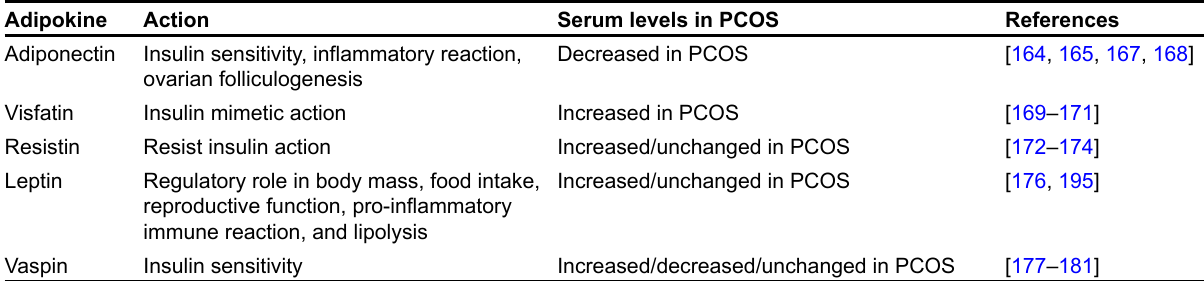
Figure 4. Proposed mechanism of interconnection between adiposity, hyperinsulinemia, chronic low-grade inflammation and hyperandrogenemia in PCOS Table 1. Adipokines and observations in